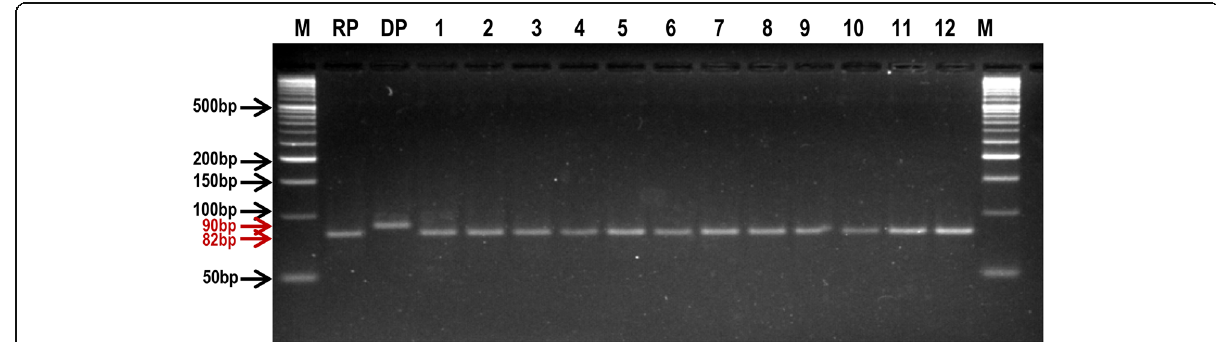
Fig. 10 A representative image showing the amplification profile of the marker, “ nksbad2 ” based on 8 bp deletion in badh2 in the PB 1121 HT- NILs along with recurrent parent (RP), PB 1121 and the non-aromatic donor parent (DP) Robin. M: 50 base pair DNA ladder, RP: PB 1121, DP: Robin, 1 – 12: PB 1121 HT-NILs, Pusa 1979-14-7-33-99-8, Pusa 1979-14-7-33-99-10, Pusa 1979-14-7-33- 99-15, Pusa 1979-14-7-33-99-34, Pusa